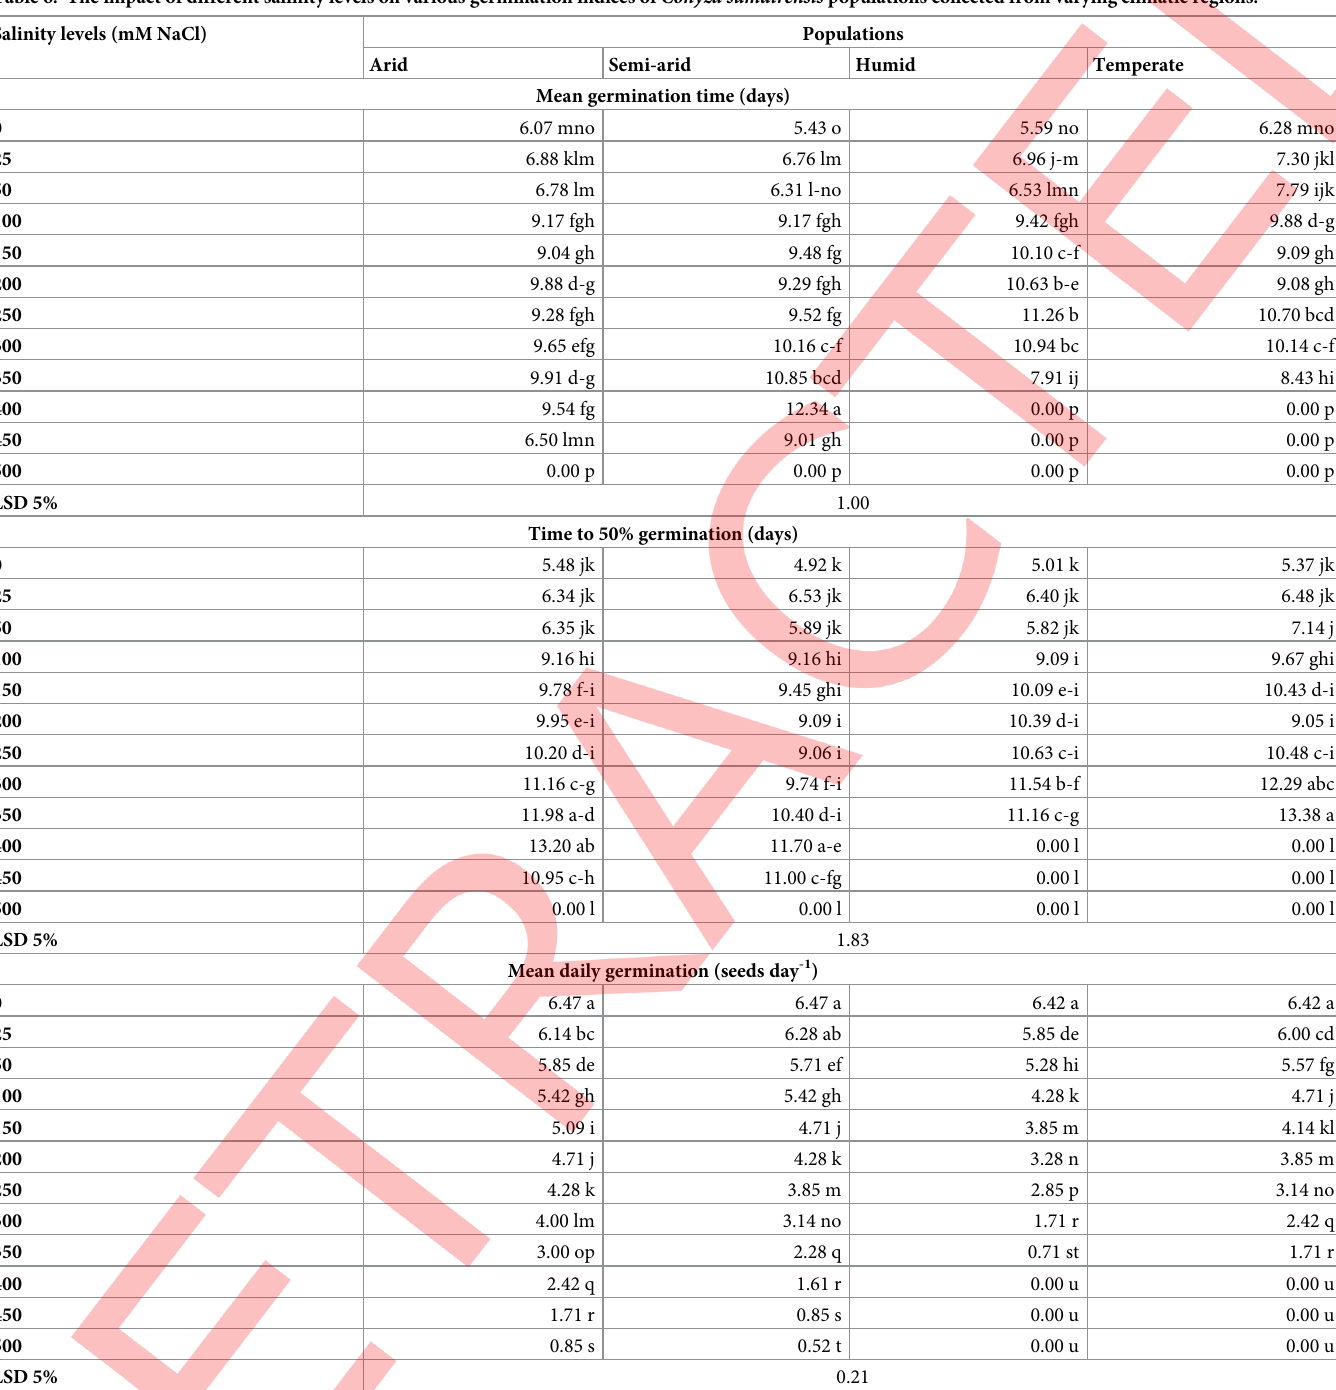
Table 6. The impact of different salinity levels on various germination indices of Conyza sumatrensis populations collected from varying climatic regions. Salinity levels (mM